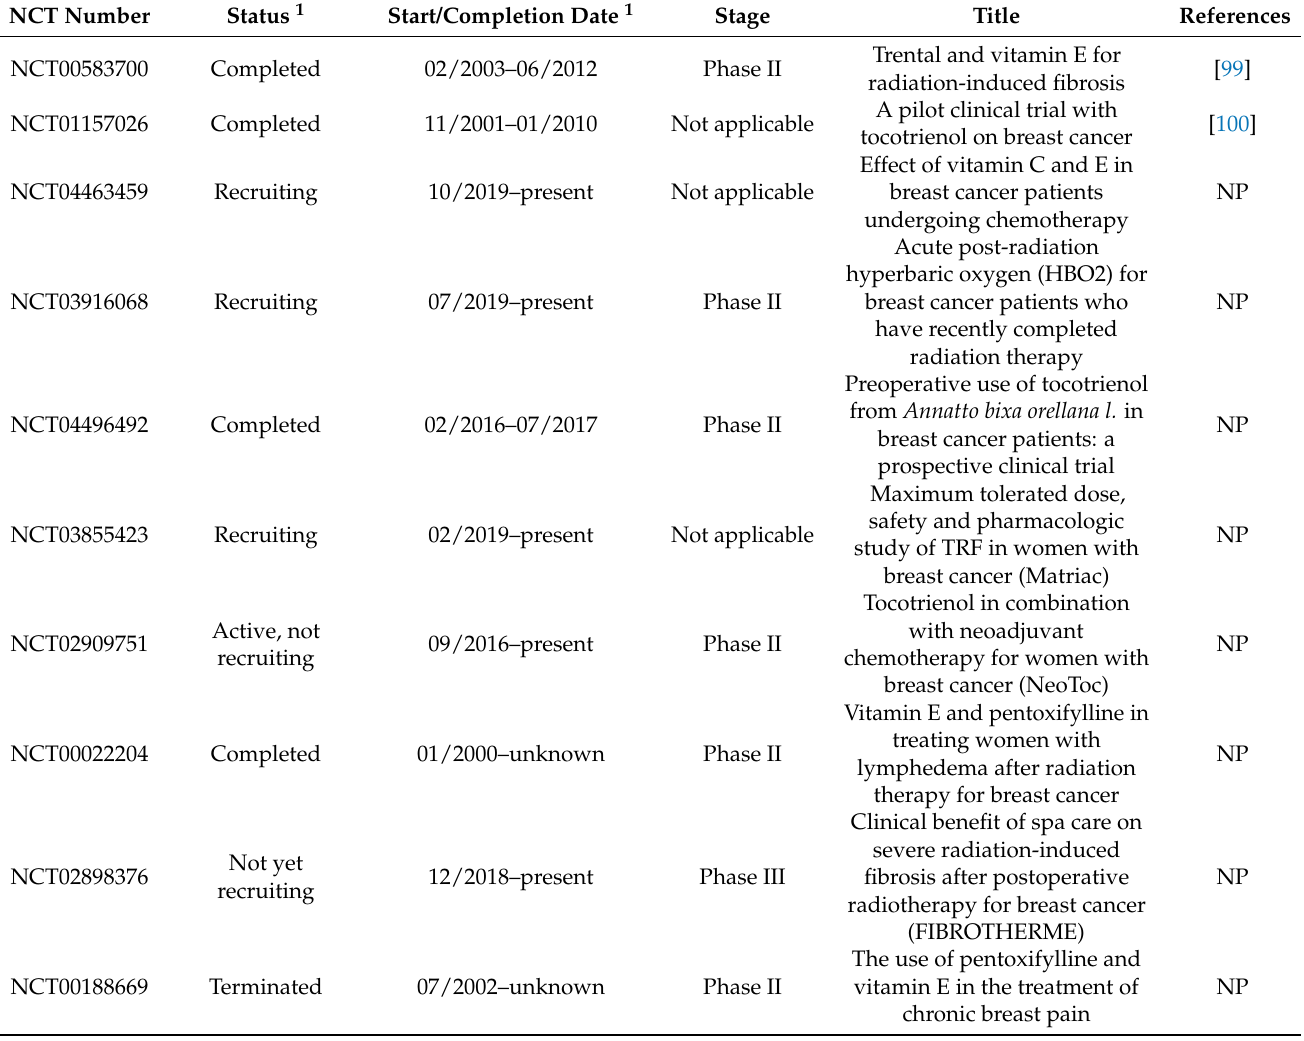
Table 4. Clinical trials with vitamin E in breast